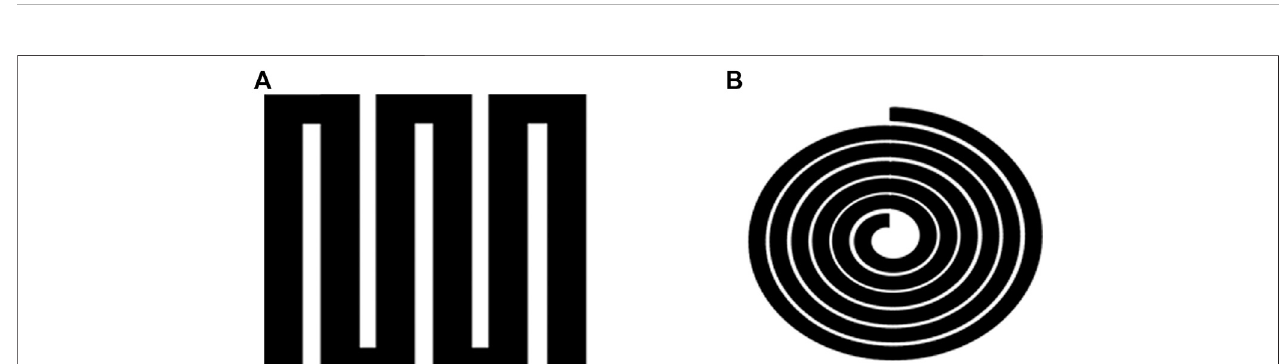
Frontiers in Chemistry |